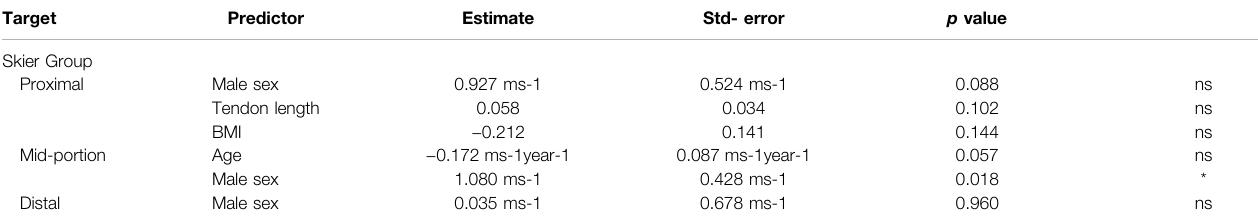
TABLE 3 | Predictive factors of shear wave velocity in the skier group. In the control group, no predictive factors were identi fi ed.